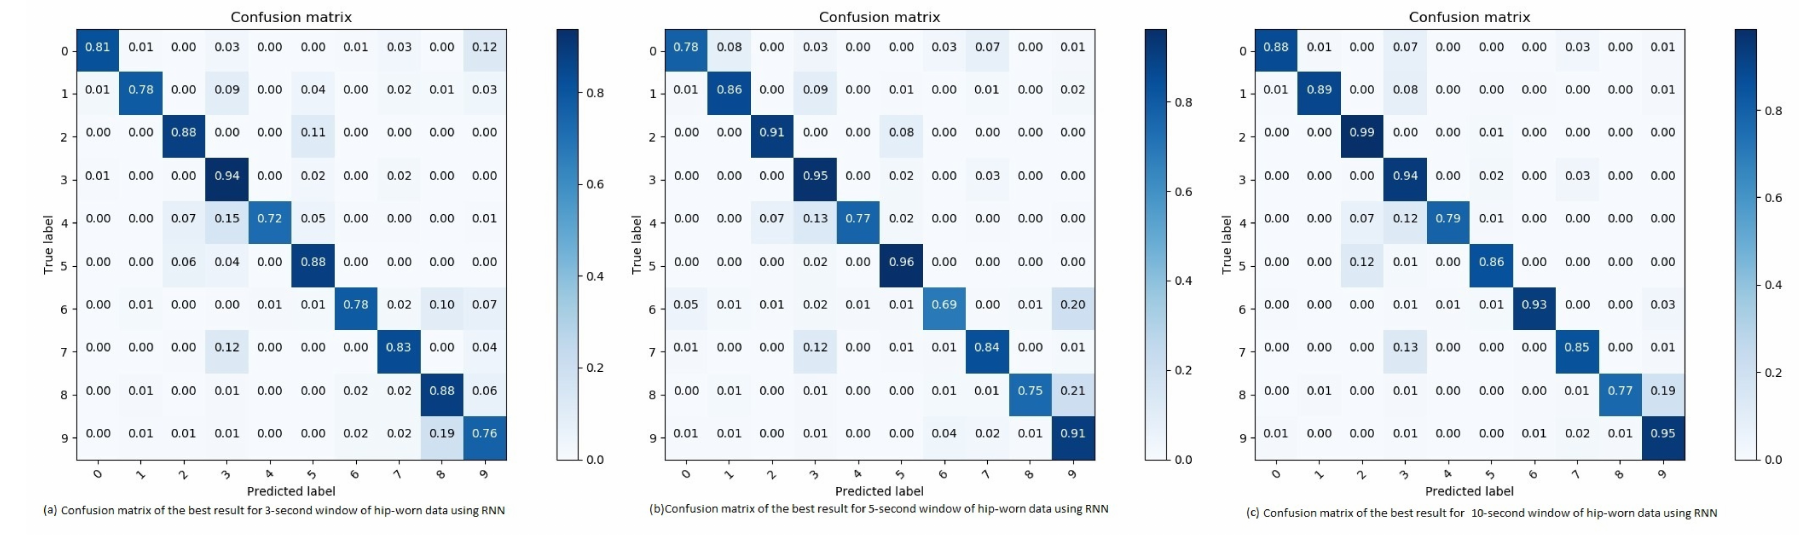
Figure 11. Confusion matrix of the best result for 3, 5, 10-s window of hip-worn data using